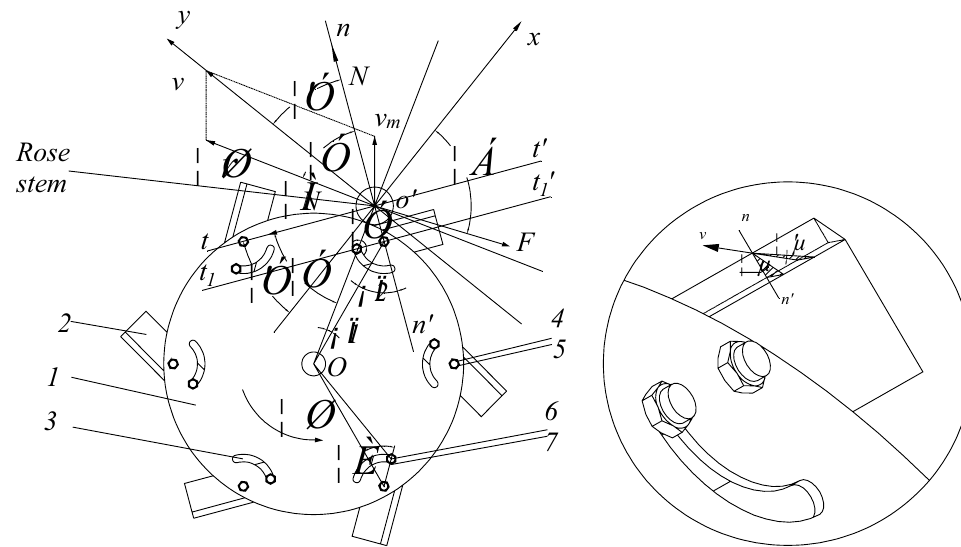
Figure 3. Improved disc cutter. Note: 1, cutter head; 2, blade; 3, Bolt A; 4, Nut A; 5, Bolt B; 6, Nut B; 7,